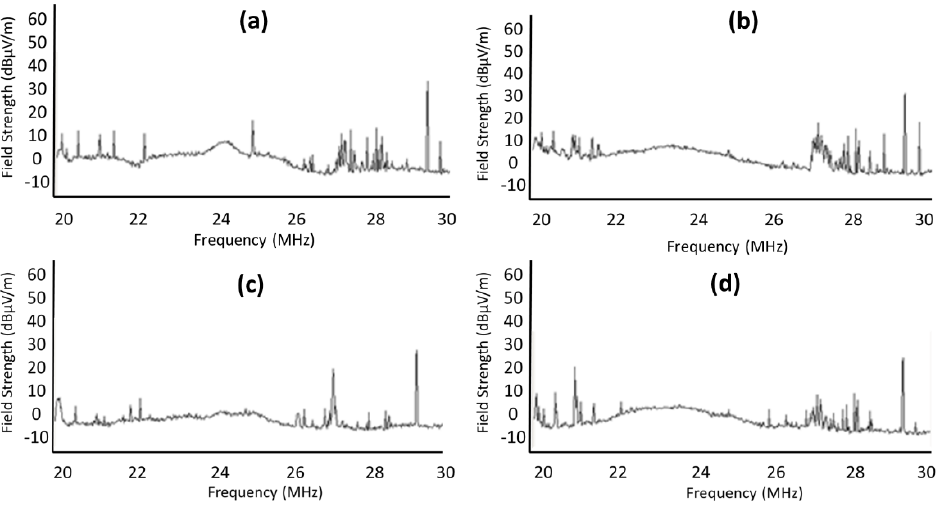
Figure 18. 20-30 MHz ( a ) East – West, ( b ) North – South, ( c ) West – East, and ( d ) South –